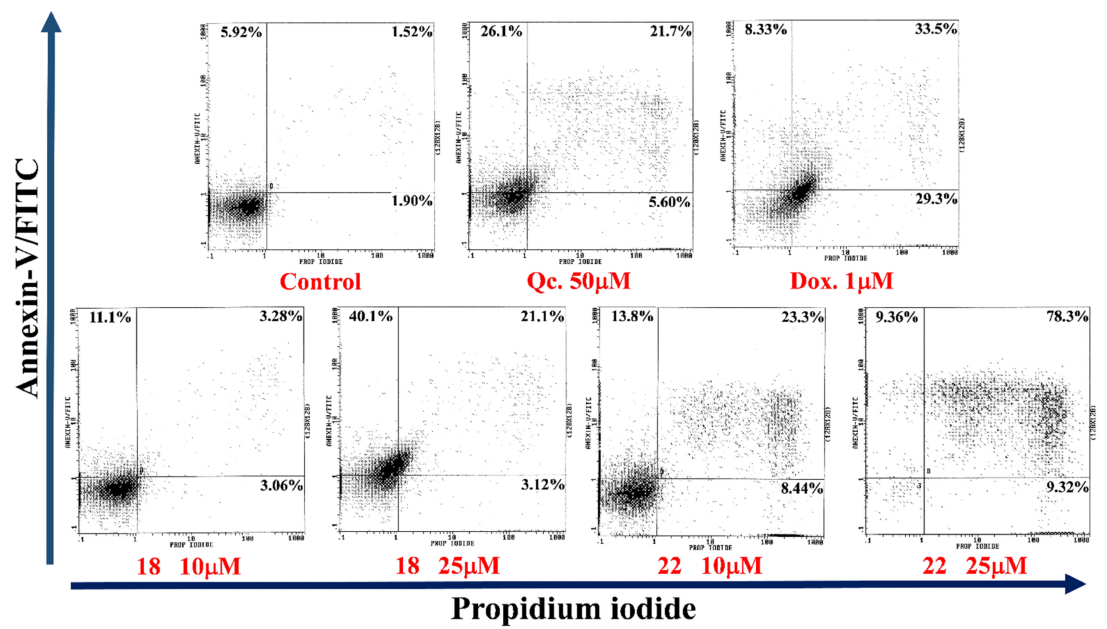
Figure 3. Effect of compounds 18 and 22 on apoptosis and necrosis of human A549 cell line assessed by flow cytometry. Early apoptosis was defined by annexin V-FITC brightness; necrosis expression by PI and late apoptosis by double positiveness. The double plots illustrate the effect of 24 h incubation with compounds 22 and 18 (10 and 25 µ M), Qc: quercetin (50 µ M), Dox: doxorubicin (1 µ M), and